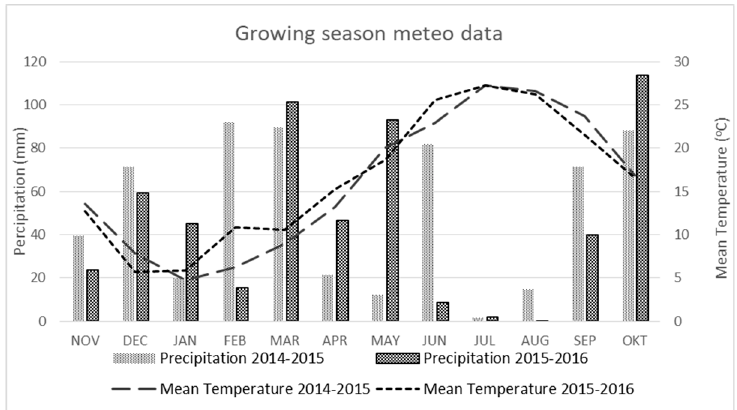
Figure 1. Monthly means of average air temperature ( ◦ C) and precipitation (mm) for the 2014–2015 and 2015–2016 growing